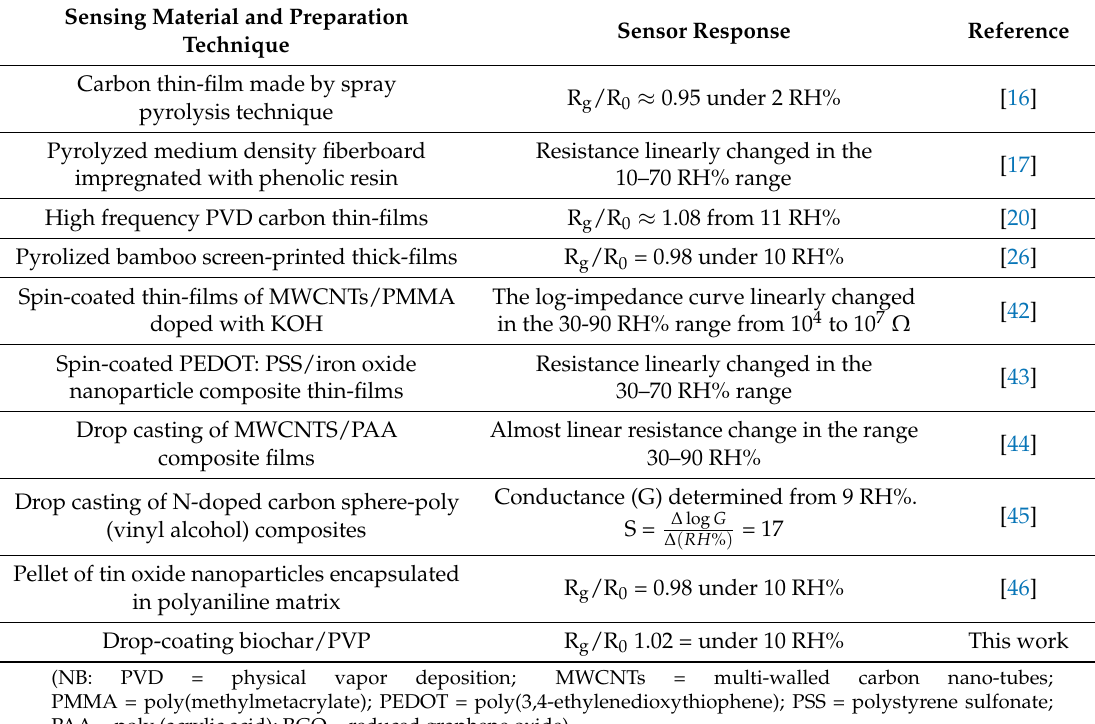
Table 7. Response toward humidity of carbon-based and of composite polymer-based resistive sensors at room